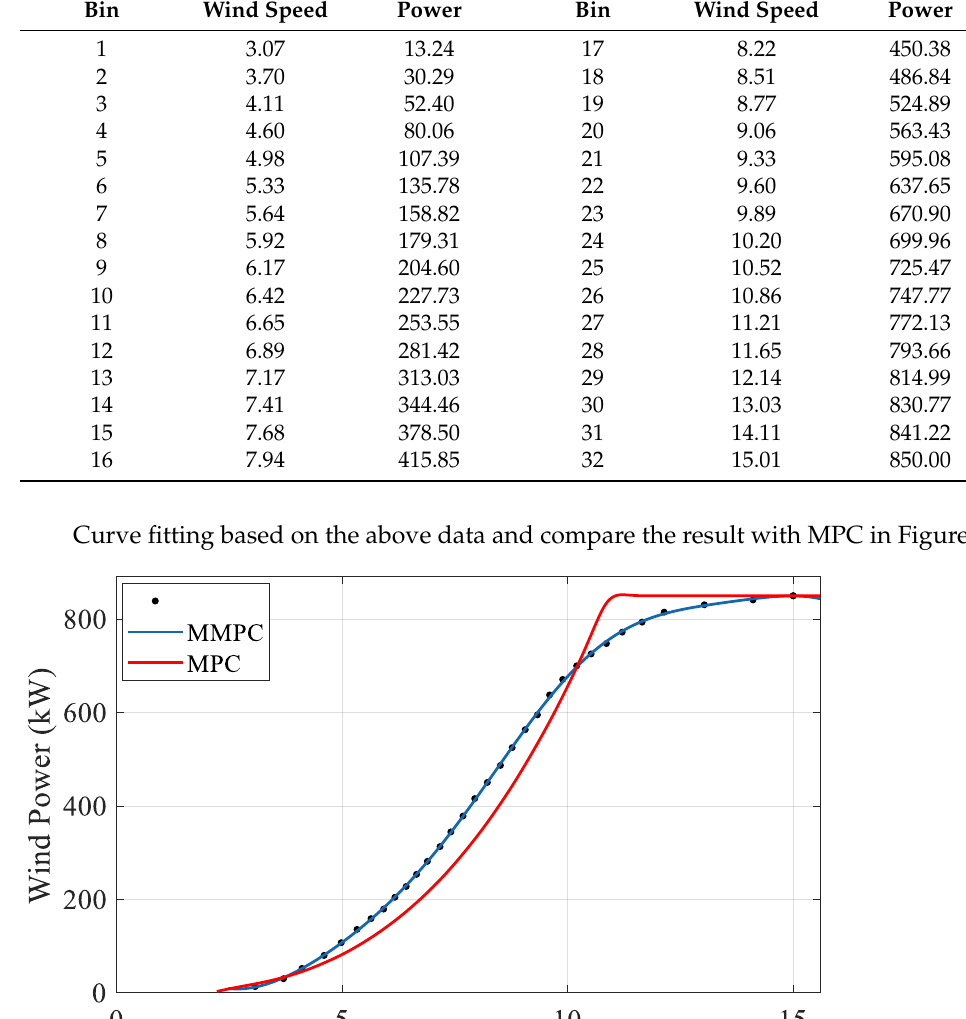
Table 3. Data aggregation equivalent point.